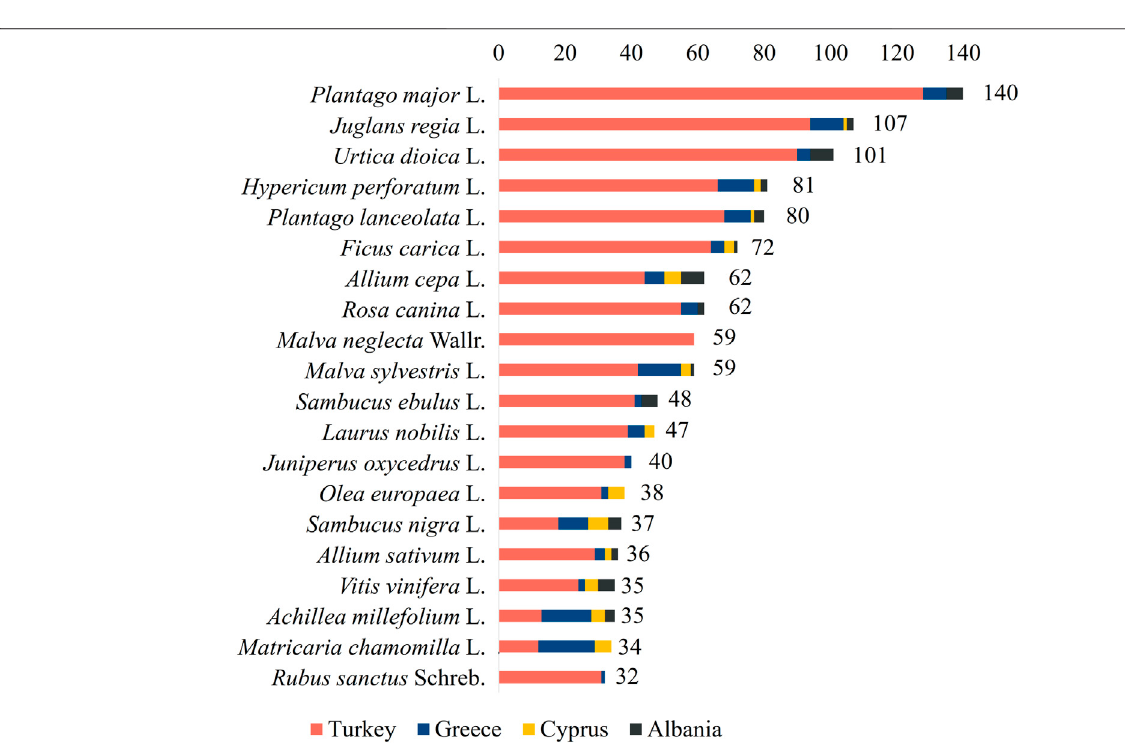
Frontiers in Pharmacology |